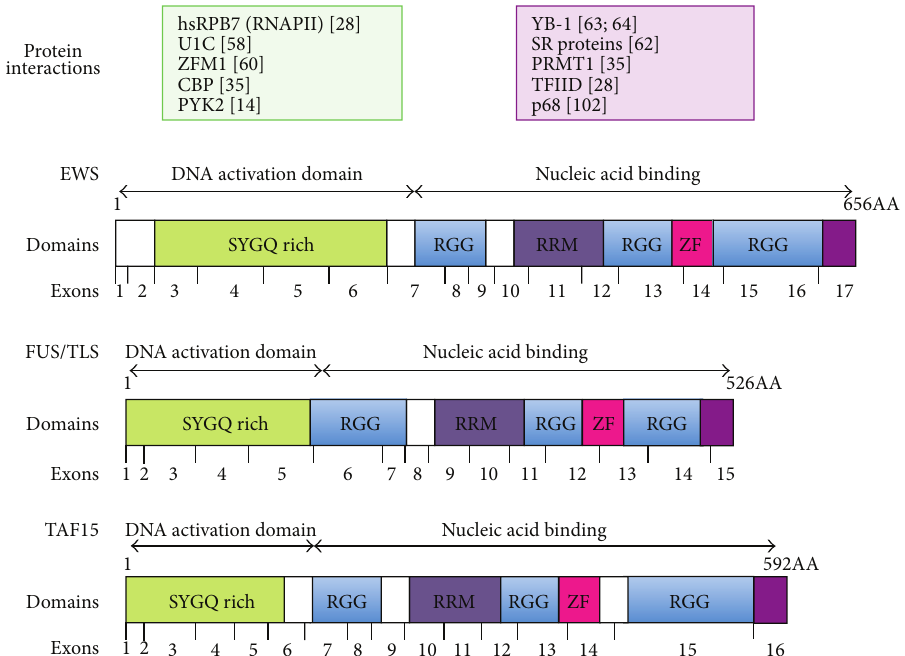
Figure 1: Domain structure of TET proteins: the N-terminal activation domain and the C-terminal nucleic acid binding domain of TET proteins are schematized: the SYGQ rich domain, RGG boxes, and the RNA binding domain (RBD), Cys2-Cys2 zinc finger (ZF). Below the scheme, the exons encoding each domain are indicated for EWS, FUS/TLS, and TAF15, respectively [17, 18]. In the upper part of the figure the proteins that have been described to interact with either the DNA activation domain or the nucleic acid binding domain of EWS are listed.